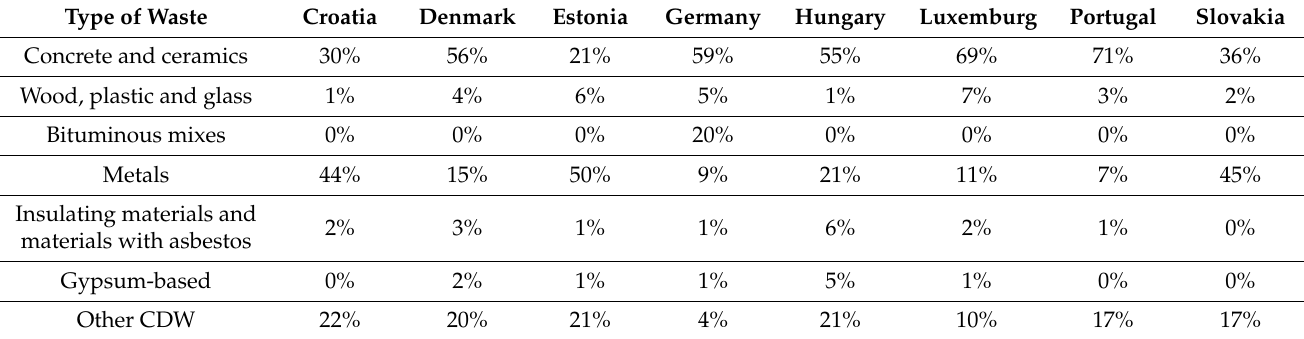
Table 1. CDW by type and country. Percentages by weight. Source [8], based on data from EUROSTAT. Type of